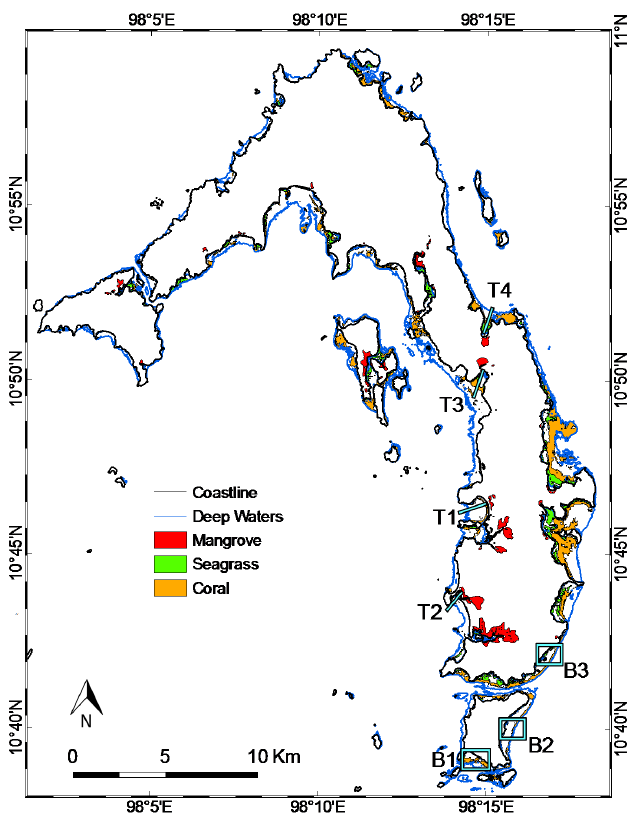
Figure 5. Map showing mangrove, seagrass, and coral distribution obtained from the classification of OLI image. T1-T4 identify transects of biodiversity hot-spots, B1–B3 identify bays where the OLI classification results were compared with finer spatial resolution RapidEye imagery.